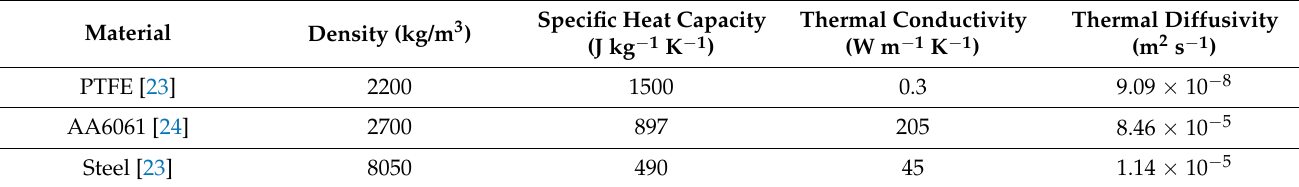
Table 1. Thermal properties of tested